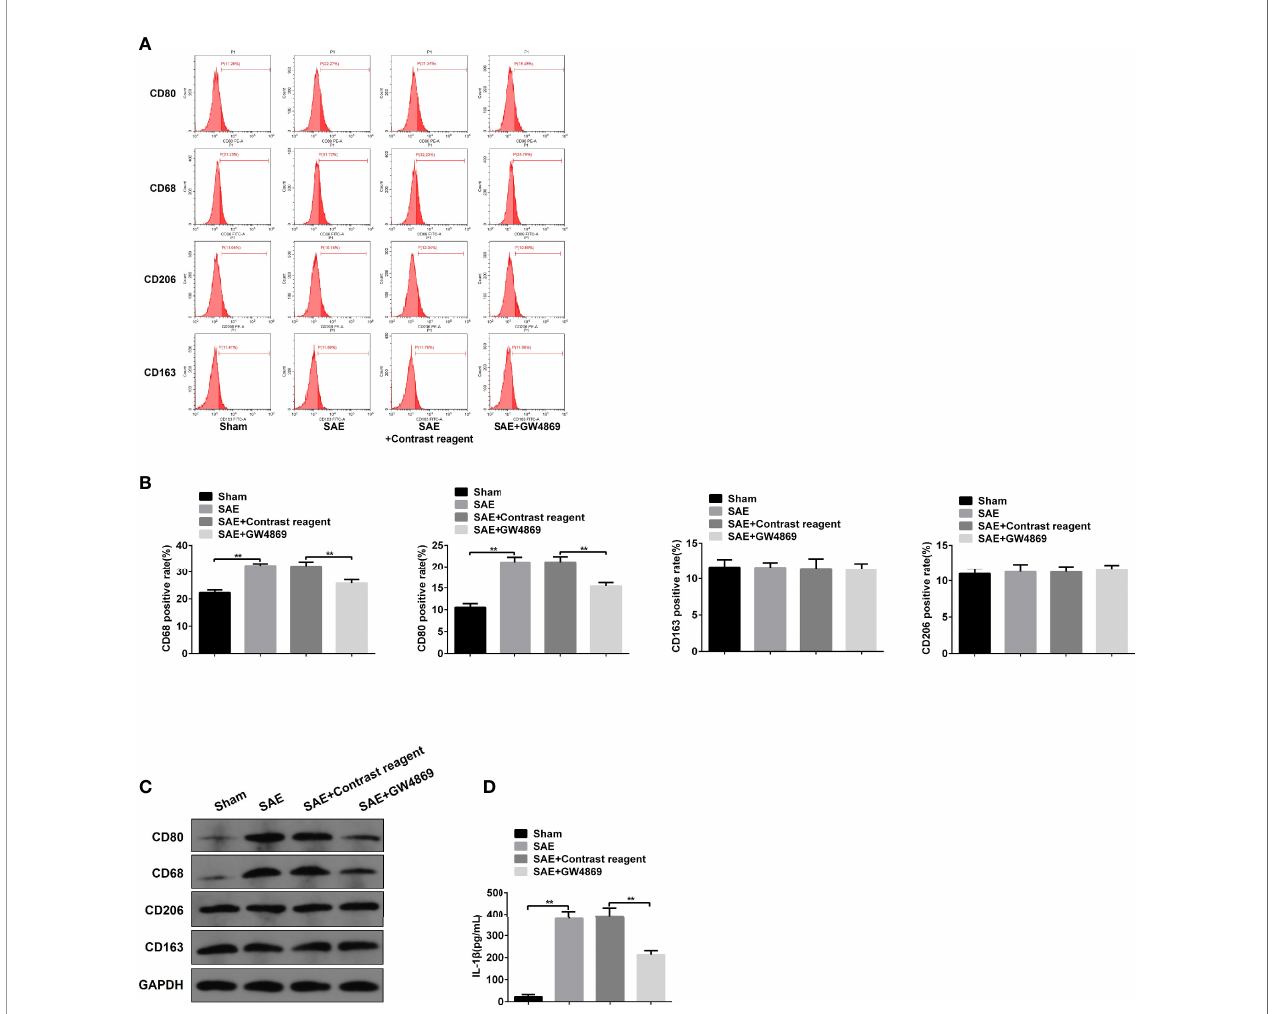
FIGURE 5 | Effects of GW4869 on M1 polarization in SAE rats. (A) Rats were processed with Sham control surgery and CLP treatment. In CLP-induced SAE rats, rats were challenged with control reagent or GW4869 administration. And CD80-, CD68-, CD206-, and CD163-positive cells in mesenteric lymph nodes were measured by fl ow cytometry. (B) Quantitative analysis of the proportion of CD80-, CD68-, CD206-, and CD163-positive cells in panel (A) of this fi gure. (C) Protein expression of CD80, CD68, CD206, and CD163 as determined by WB in the isolated cells from different rats. (D) The level of IL-1 b was detected by ELISA kits. **P <